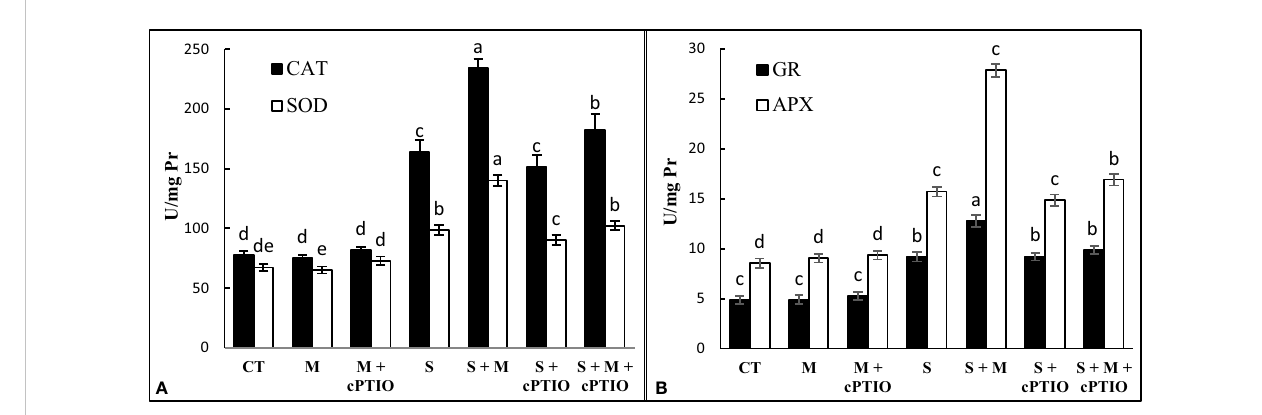
FIGURE 3 The leaf activities of catalase (CAT, A ), superoxide dismutase (SOD, A ), ascorbate peroxidase (APX, B ), and glutathione reductase (GR, B ) enzymes in tomato seedlings treated with melatonin (150 m M) and cPTIO (100 m M) under NaCl (150 mM) treatment. Different letters in each column show signi fi cant differences at the p < 0.05 based on the LSD test (means ± SD, n = 5), CT, control treatment; M, melatonin; S,